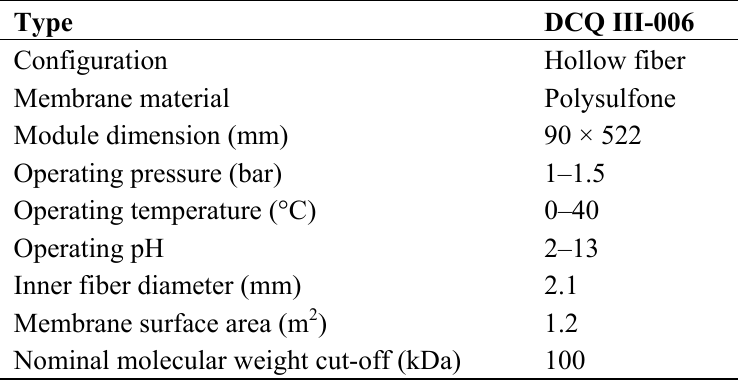
Table 1. Characteristics of the UF membrane